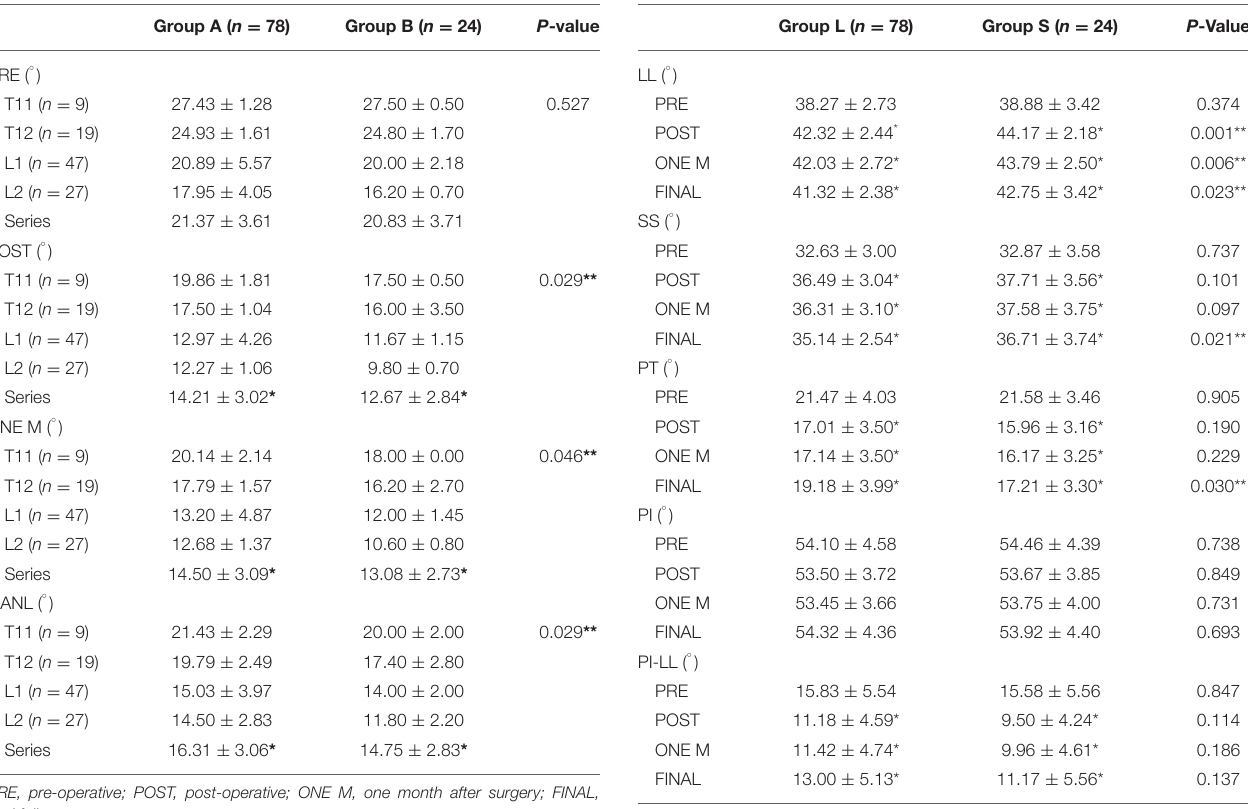
TABLE 3 | Local kyphotic angle of fractured vertebrae of both groups. TABLE 4 | Spino-pelvic sagittal balance parameters of both